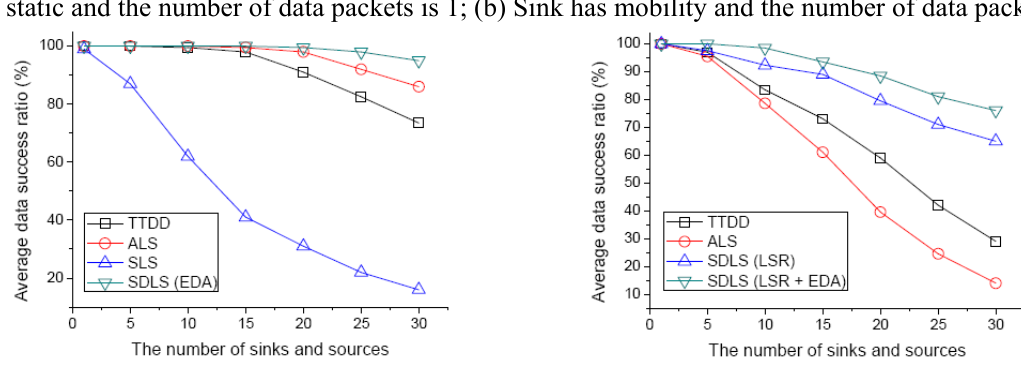
Figure 9. Average data success